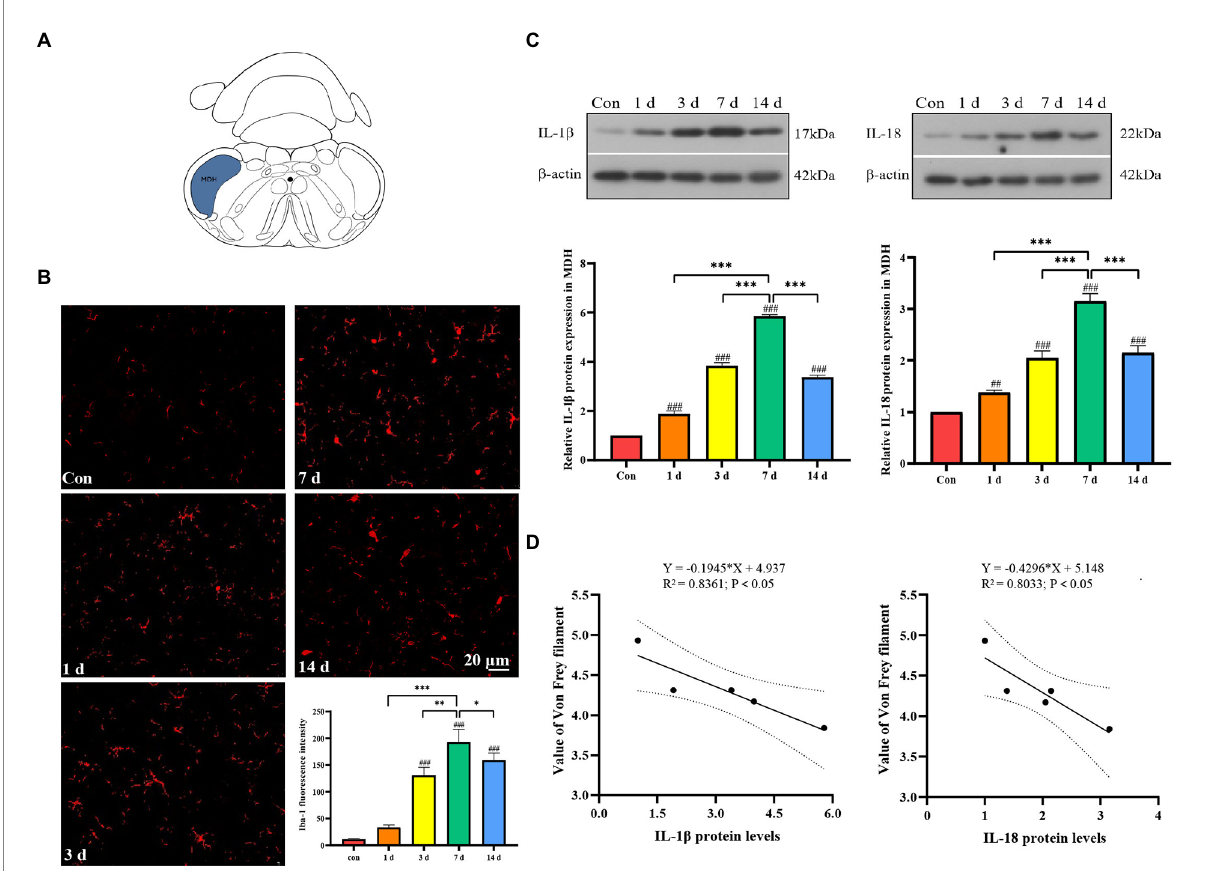
FIGURE 2 Activation of microglia and release of inflammatory factors in medullary dorsal horn (MDH) after dental pulp exposure. (A) The location of the MDH in the representative coronal brain slices schematic diagram. (B) The expression of Iba-1 after dental pulp exposure. (C) The protein levels of IL-1 β and IL-18 in MDH. (D) Pearson correlation analysis of the withdrawal threshold and IL-1 β and IL-18 protein levels in MDH. * p < 0.05, ** p < 0.01 vs. 7 d group, *** p < 0.001 vs. 7 days group, ## p < 0.01, ### p < 0.001 vs.